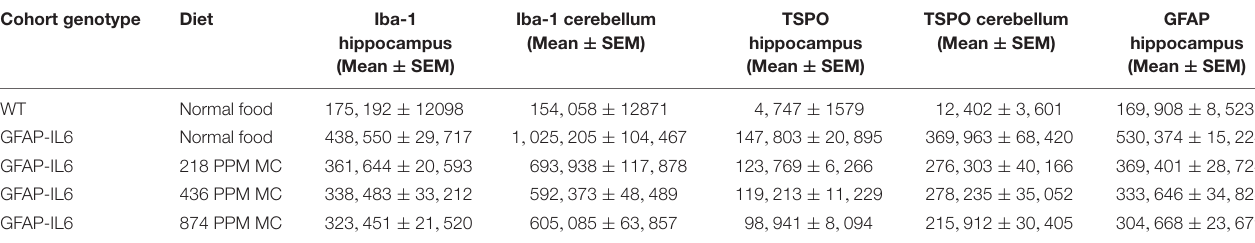
TABLE 2 | Stereological counting summary.